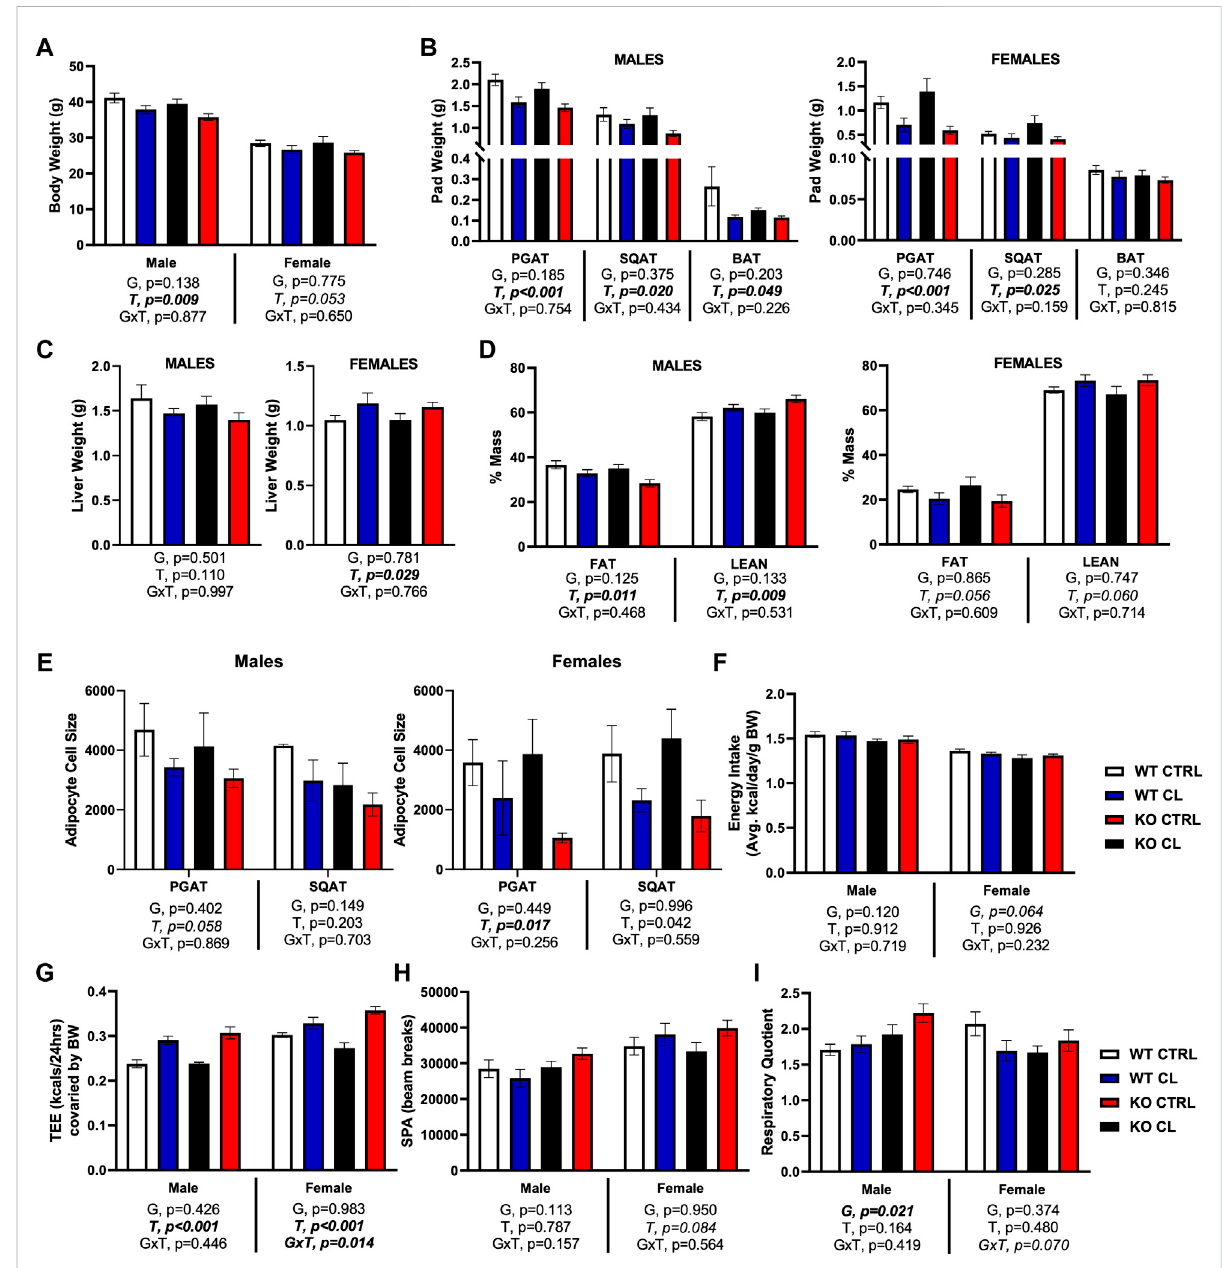
FIGURE 2 ER β genomic activity is not required for CL-induced improvements in body composition and energy expenditure. Male and female C57BL/6J wild-type(WT)orEstrogenReceptorBeta(ER β )DNAbindingdomainknockout(ER β DBD KO)mice,allonHFD,weregiven2-weeksCLinjection(1ug/g body wight) or CTRL (saline) prior to body composition and energy expenditure assessment. (A) Final body weight. (B) Perigonadal (PGAT), subcutaneous (SQAT) and brown (BAT) adipose tissue pad weights. (C) Liver weight. (D) % Fat mass and % Lean mass. (E) PGAT and SQAT average adipocyte size. (F) Energy intake. (G) Total energy expenditure. (H) Spontaneous physical activity. (I) Respiratory quotient (RQ). All data are presented as mean ± SEM. N = 8 – 11 per group. Main effects of genotype (G) and CL treatment (T) and genotype by treatment interactions (GxT) for each sex were determined by 2 × 2 ANOVA and are presented below the respective fi gures. Post hoc Tukey ’ s tests were used to identify individual group differences in cases where signi fi cant interactions were found. p -value < 0.05 accepted as signi fi